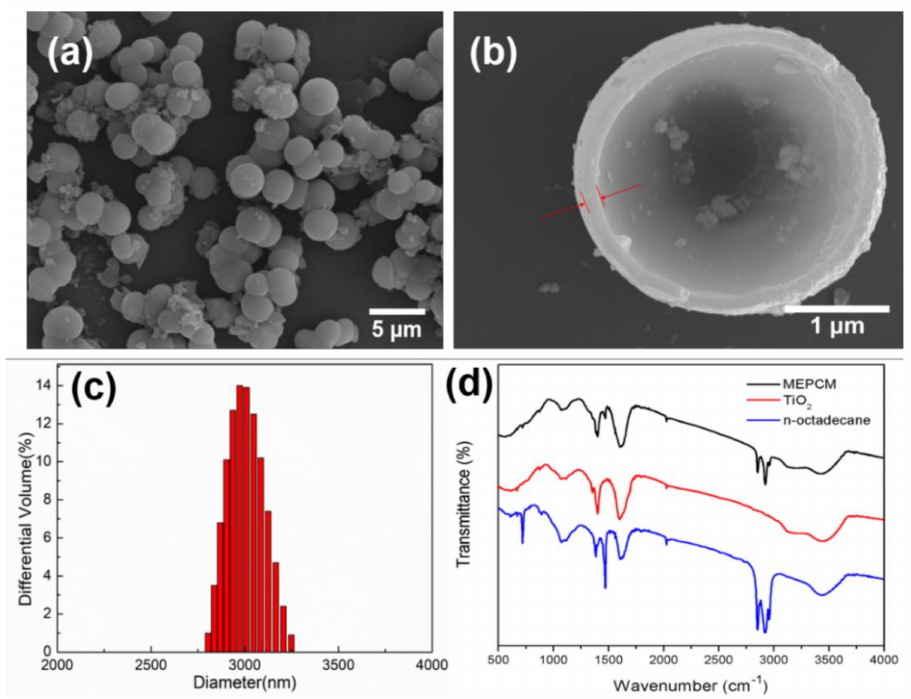
Figure 3. Characterizations of phase-change microcapsule: ( a ) FESEM image of MEPCMs; ( b ) Microstructure of the microcapsule; ( c ) Size distribution of the MEPCMs; ( d ) FT-IR spectra of the